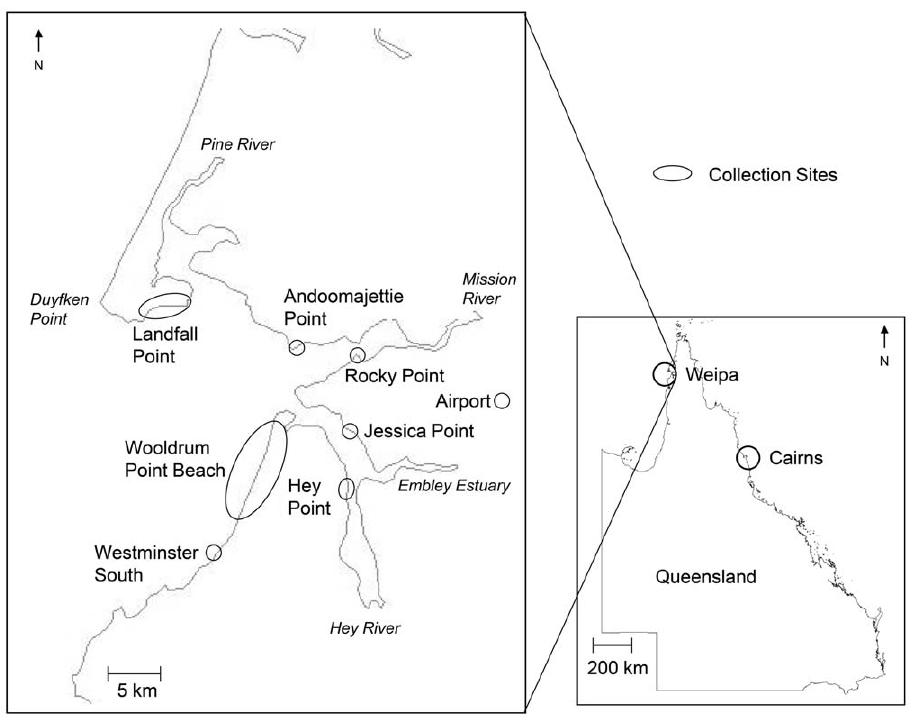
Figure 1. Geographic location of Weipa medusae collection sites, western Cape York, north Queensland, Australia.